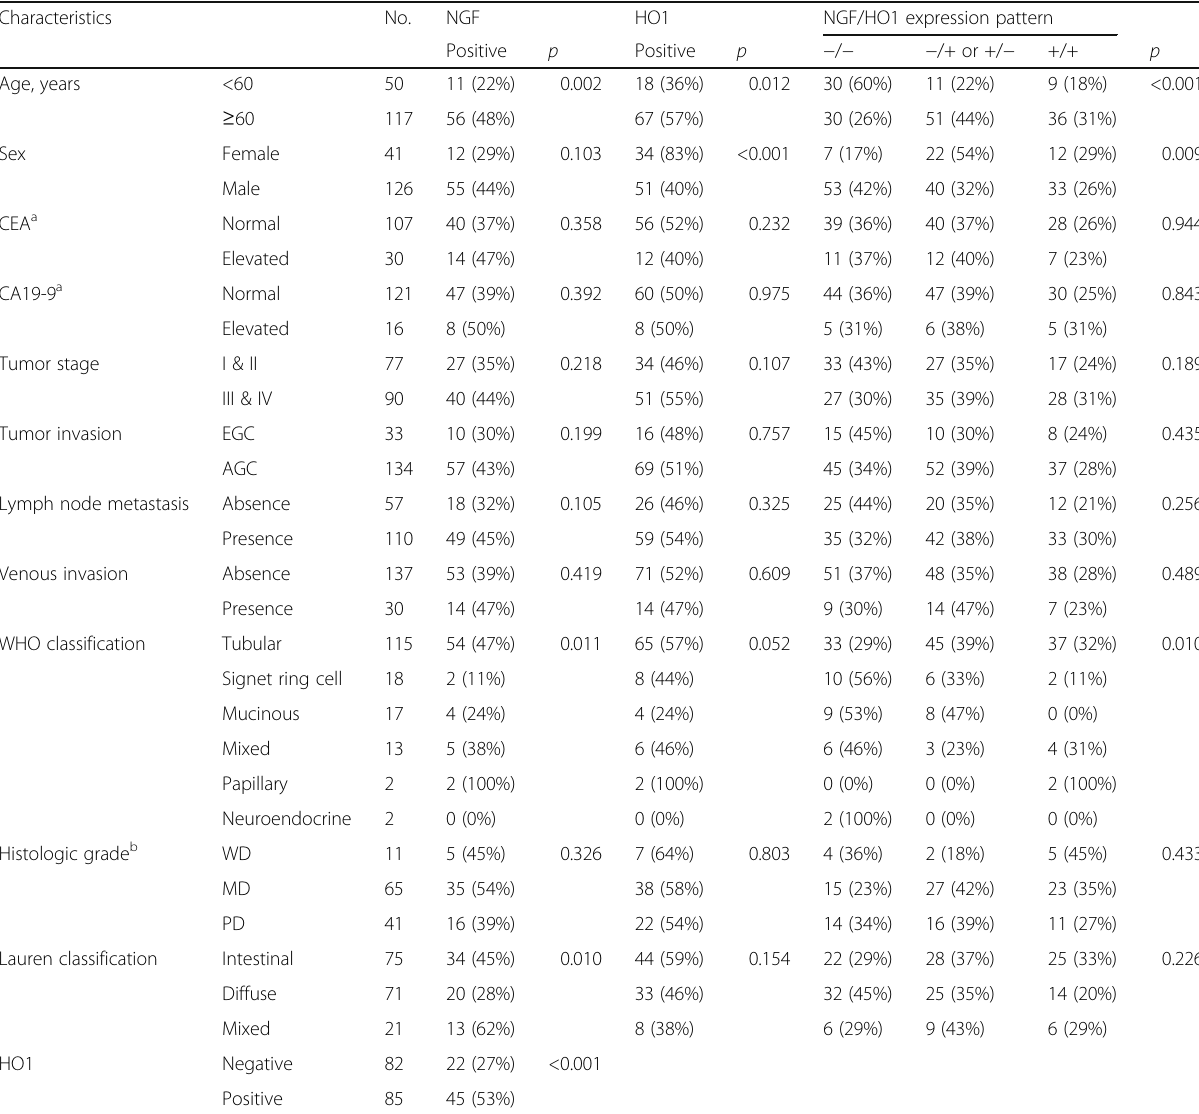
Table 1 Clinicopathologic variables and the expression of NGF and HO1 in 167 gastric carcinomas